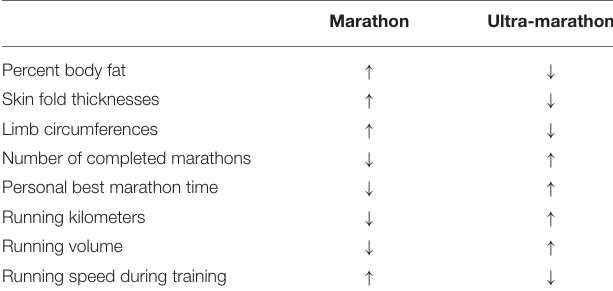
TABLE 7 | Comparison between marathon and ultra-marathon runners regarding anthropometric and training characteristics.